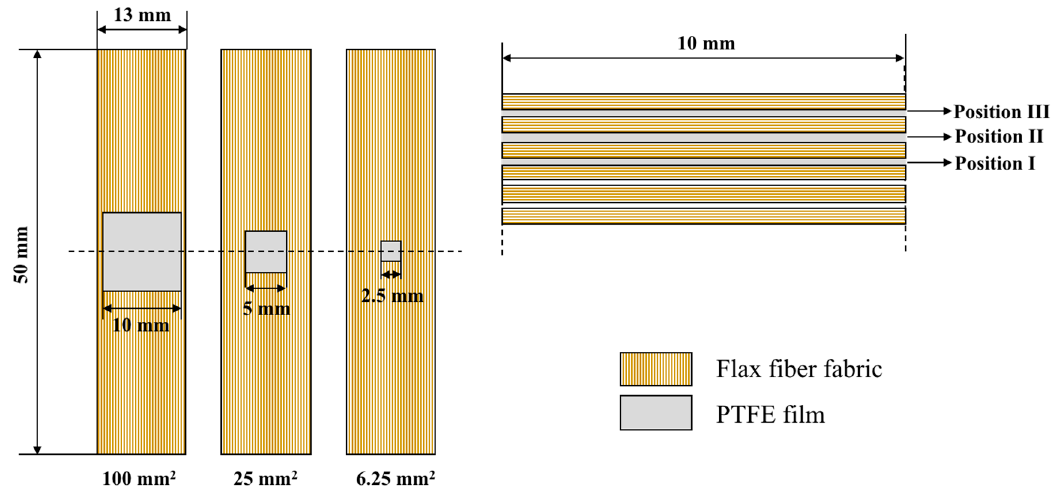
Figure 1. Schematic showing the location of the delamination introduced in the samples, and the respective identifications.